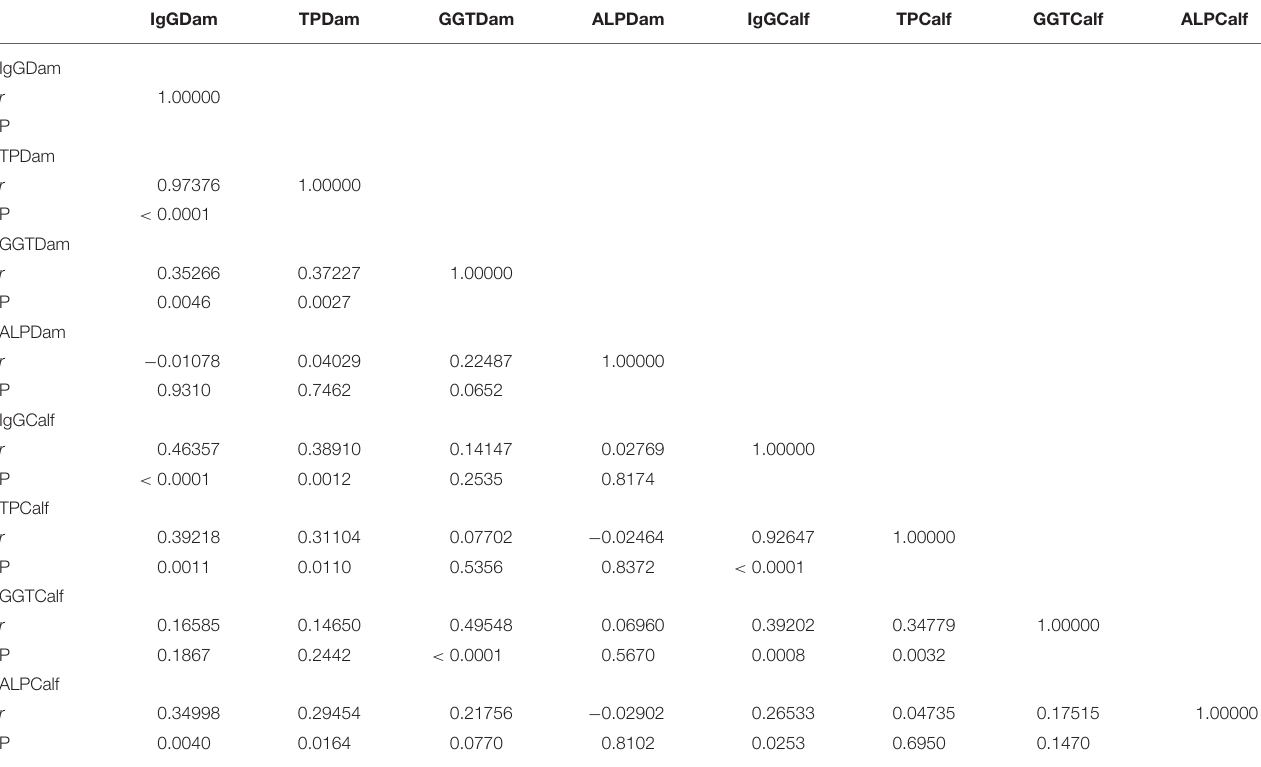
TABLE 1 | Correlation between colostrum parameters at calving and serum concentrations parameters of buffalo calves at